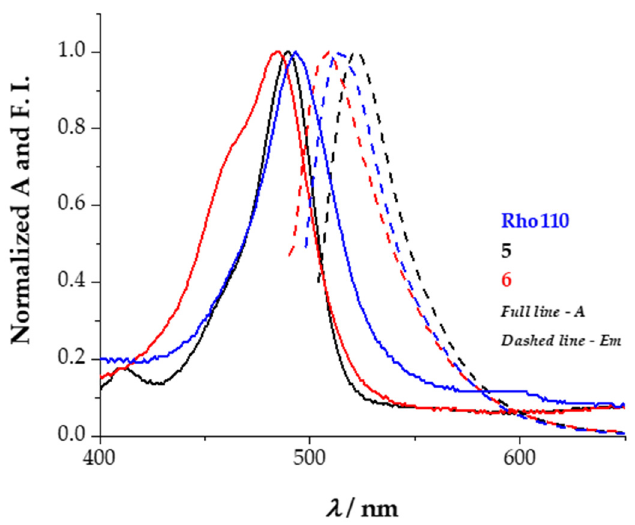
Figure 2. Normalized absorption and emission spectra of Rho110 (blue), 5 (black, quinoid form) and 6 (red, quinoid form) in CH 2 Cl 2 at 25 °C (full line—absorption spectra; dashed line—emission spectra).